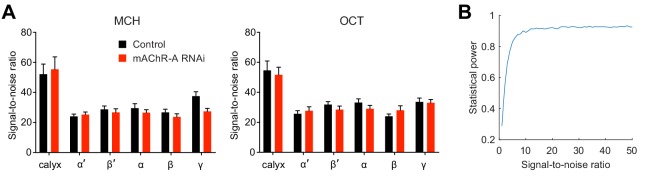
Statistical power is not affected by inter-lobe differences in signal-to-noise ratio (SNR).(A) SNR in the baseline GCaMP6f signal differs among regions of the mushroom body. SNR was measured as the reciprocal of the standard deviation of ∆F/F during the 2 s immediately preceding odor onset (the period used to calculate baseline fluorescence, or F0). SNR is mean signal divided by standard deviation; here the standard deviation of ∆F/F equals (the standard deviation of F) divided by F0, which is the mean signal during the pre-stimulus period. (B) Statistical power to detect the effect size of the difference in γ lobe odor response between control and mAChR-A knockdown flies (Cohen’s d = 1.3 for OCT, Figure 3B), for different SNRs. Statistical power did not differ for SNRs in the range observed in (A) (SNR = 20–50). Materials and method: We simulated two groups of 20 random samples (n = 20 was the smallest sample size out of the αβ and α′β′ lobes) where the effect size of the difference between the two groups was 1.3. Each sample had a ‘ground truth’ value, from which we sampled three ‘time points’ that were subject to noise with SNR from 1 to 50 (we sampled three time points because the peak of the odor response almost always occurred between 1 and 2 s after odor onset, and our frame rate was ~3 Hz). The maximum of these three time points was taken as the measured ‘peak odor response’. We ran 1000 simulations, ran t-tests on the simulated data, and counted how many gave a p-value<0.0125 (a Holm-Bonferroni correction for the four mushroom body regions that did not consistently show significant differences between control and mAChR-A knockdown flies) – this fraction is the statistical power for detecting a difference in the non-γ lobes with effect size 1.3.